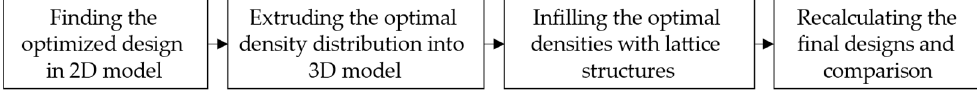
Figure 2. Overview of the procedures in this study.